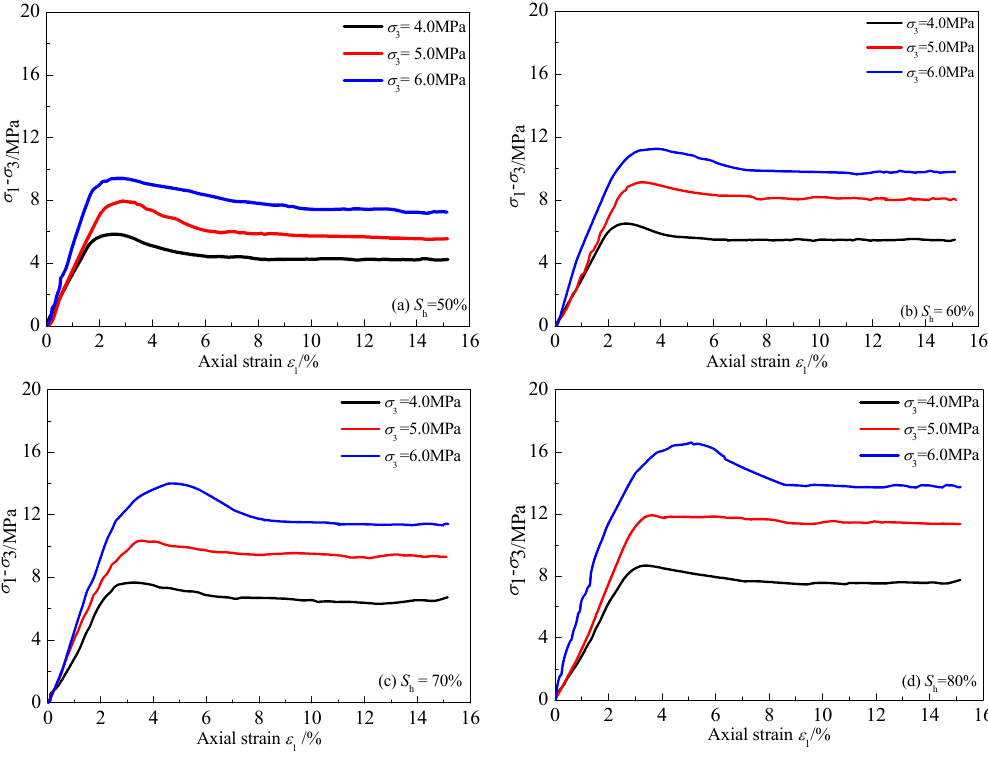
Figure 7. Stress–strain curves of the specimens.